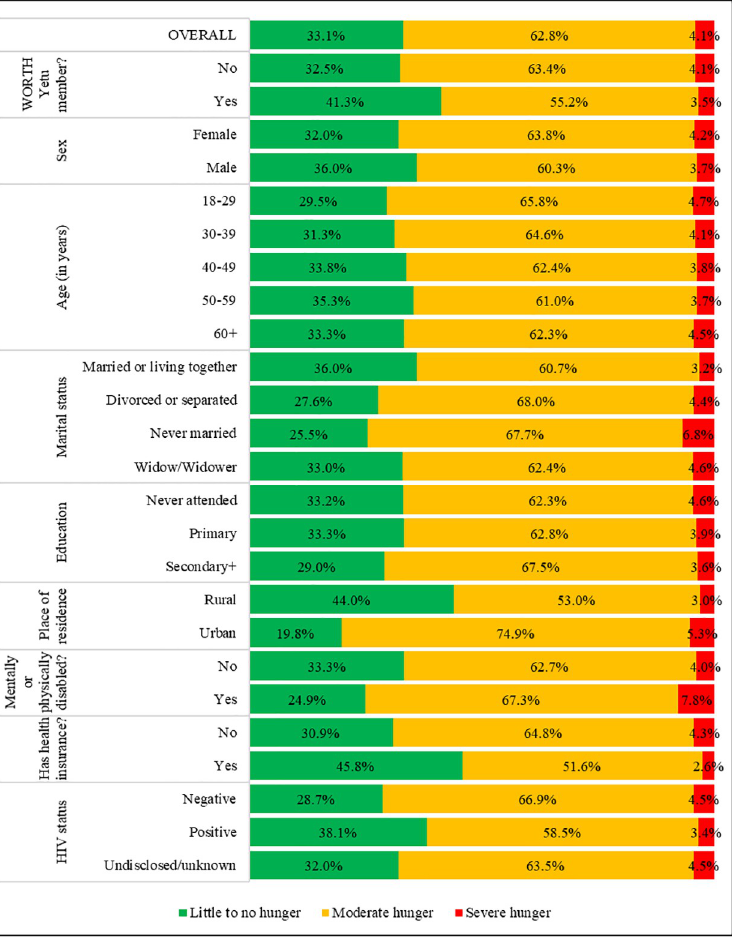
Fig 4. Caregivers’ level of household hunger at midline by background characteristics (n = 132,583).